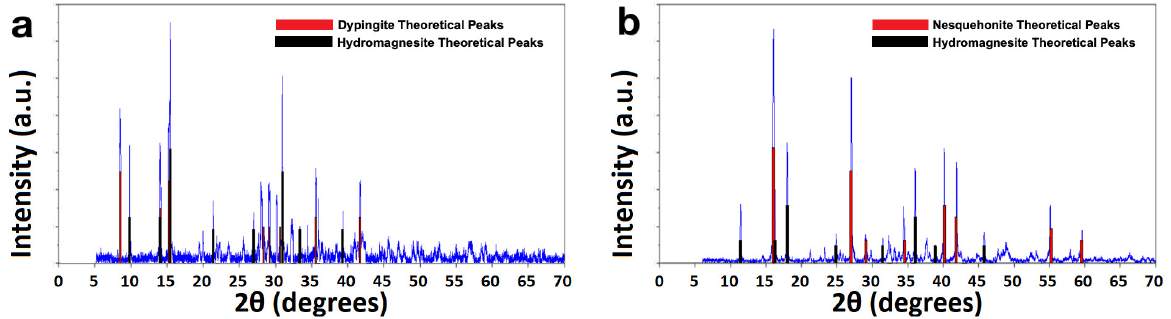
Figure 4. X-ray diffraction patterns (blue lines) of ( a ) magnesium carbonate, from aqueous route synthesis with nitrate as precursor, showing a mixture of dypingite and hydromagnesite, according to Rietveld refinement. ( b ) Magnesium carbonate, from aqueous route synthesis with sulfate as precursor, showing a mixture of nesquehonite and hydromagnesite, according to Rietveld refinement.